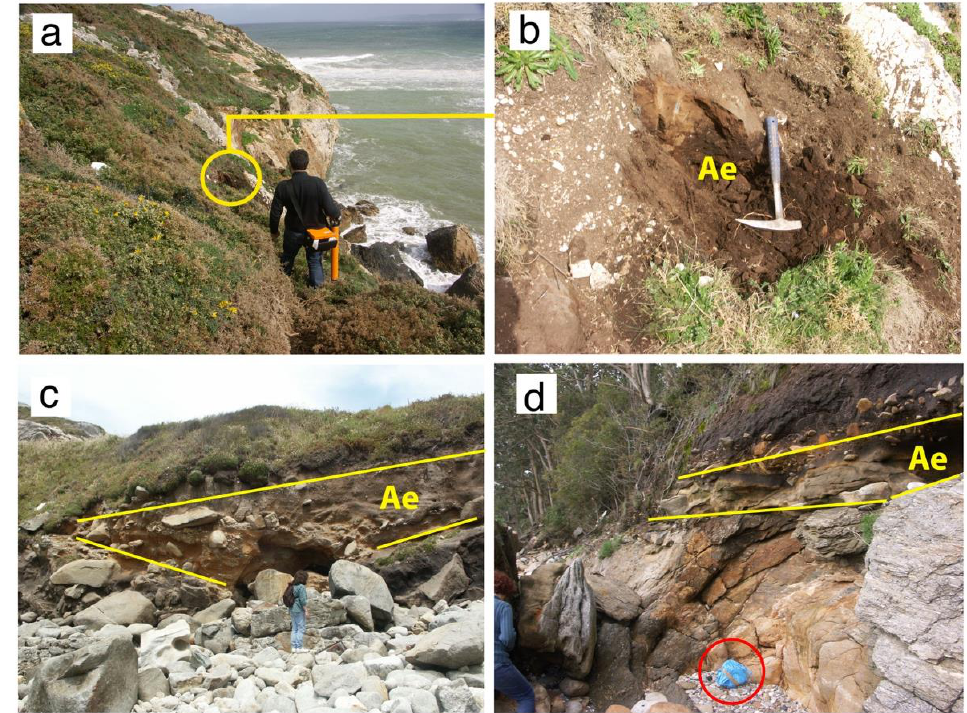
Figure 2. Images of the fossilised climbing dune outcrops Aeolian wedges (Ae) from the climbing dunes of Punta Langosteira ( a , b ), Corme ( c ) and Bornalle ( d ), usually covered by slope deposits and terrestrial vegetation [1]. The red circle shows a sampled brick ( d ).